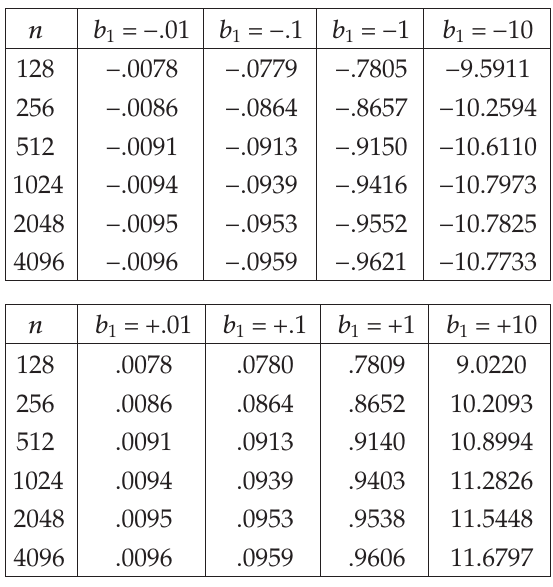
Table 6.1 . The e ff ect of discretization error on the recovery of b each section, the actual b 1 value is given above, and the values below are the computed values of b 1 using the indicated number n of spatial grid